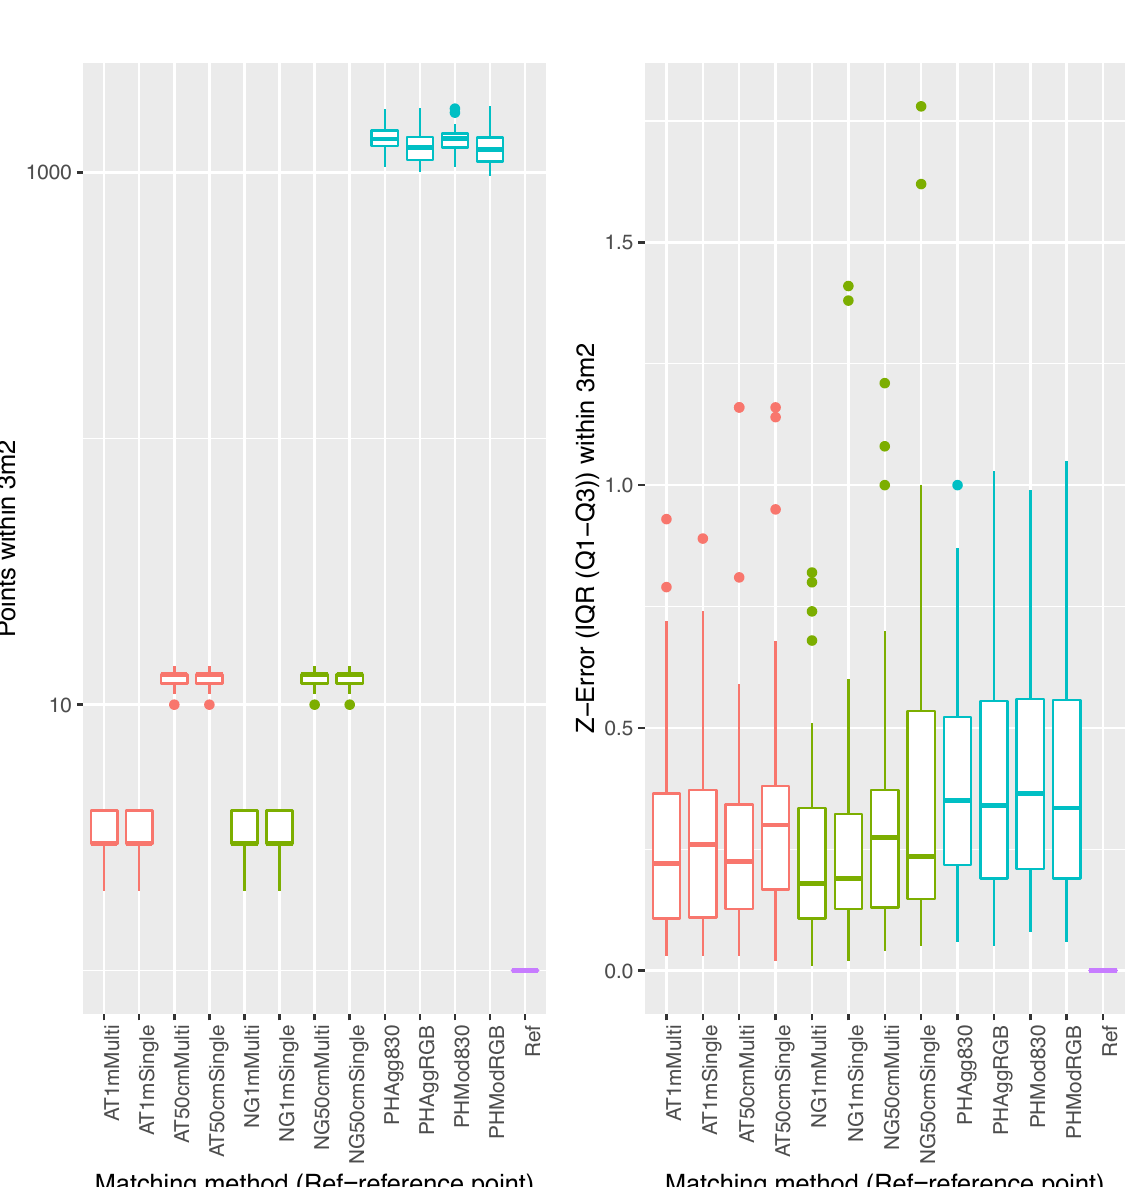
Figure 4. Extracted point clouds around reference points To avoid resampling distortions, the dense point clouds for all 3 software packages have been used to compare snow height accuracy with the reference points. The rather wide search radius of 1m around each reference point is required (Figure 4), so that more than 1 point of every dense point cloud lies within the evaluation circle. Figure 4 left reveals, that for 1m resolution with SOCET SET ATE and NGATE results only 2-4 points are within each extracted 3m 2 point cloud. Figure 4 right shows how much the extracted heights within the 3m 2 circle scatter, mainly due to local terrain undulations. 50% of all height values in the 3m 2 evaluation point cloud for all 20 reference points vary about 20cm in height for SOCET SET ATE and NGATE. The high number of